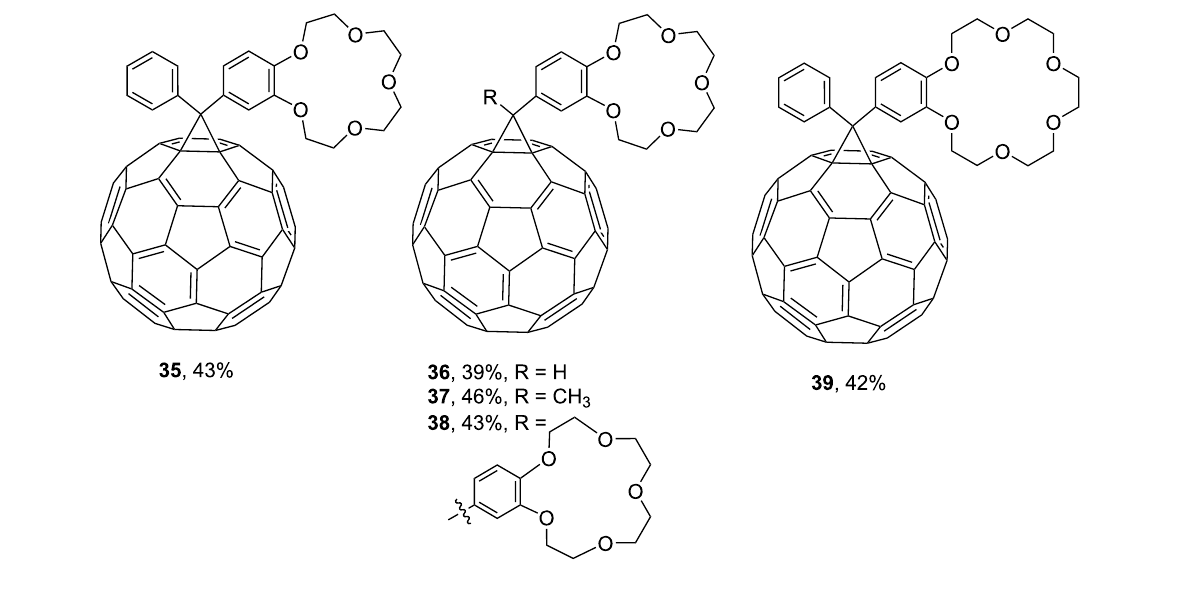
Figure 4: Conjugates of benzocrown ethers with phenylmethanofullerenes 35 – 39 .